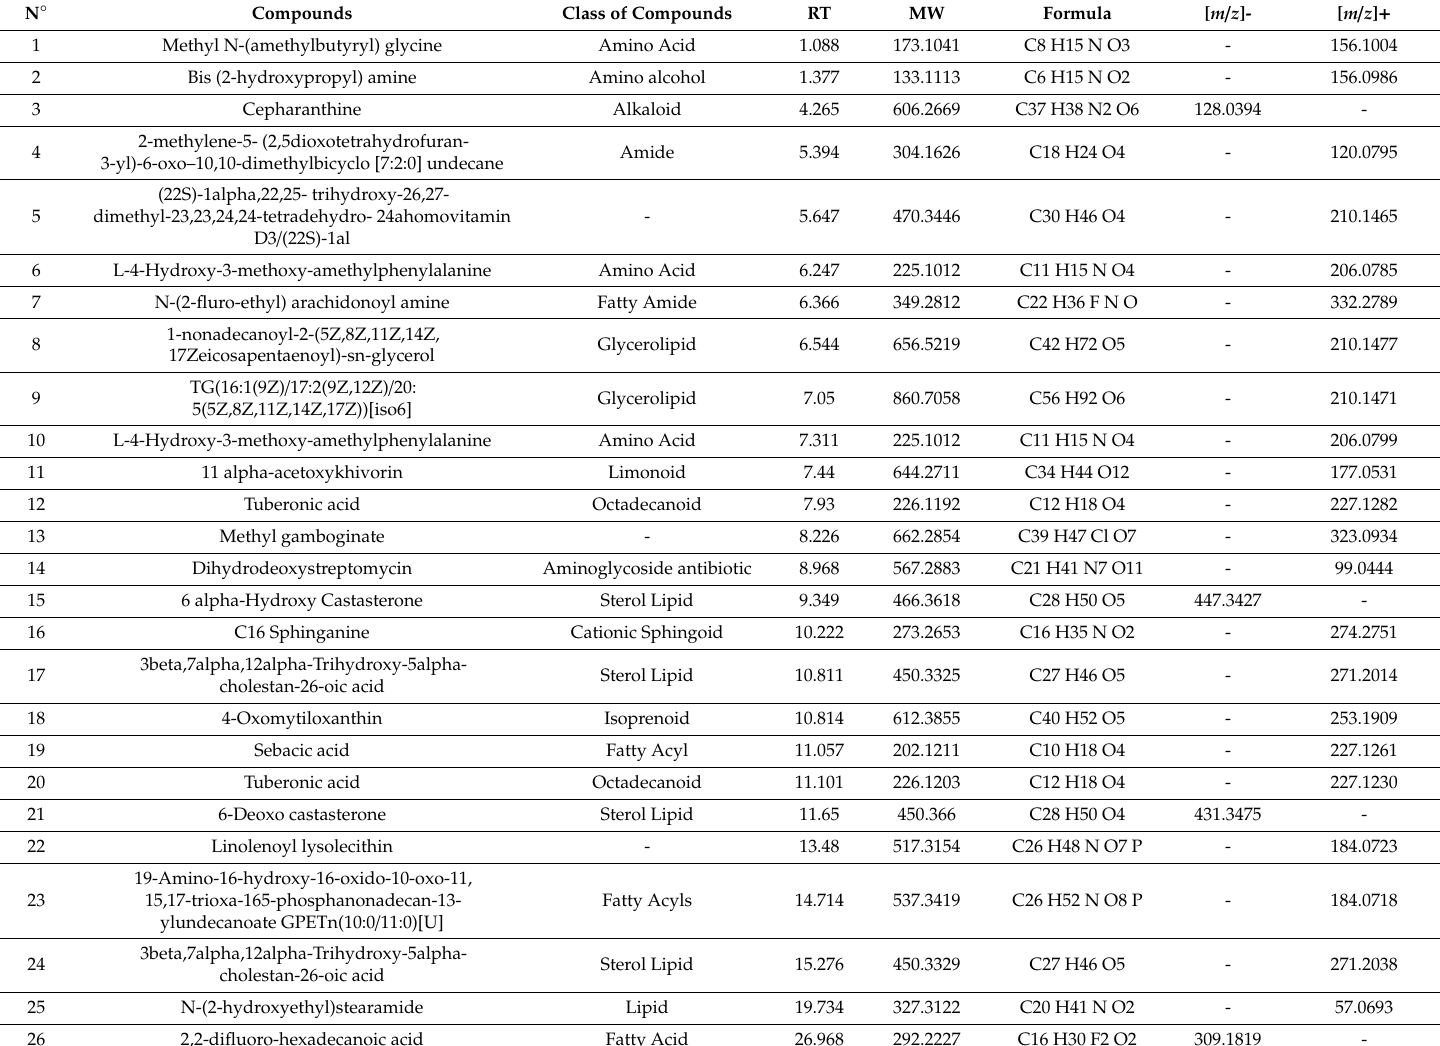
Table 1. Phytochemical composition of A. subhirsutum methanolic extract using the HR-LCMS